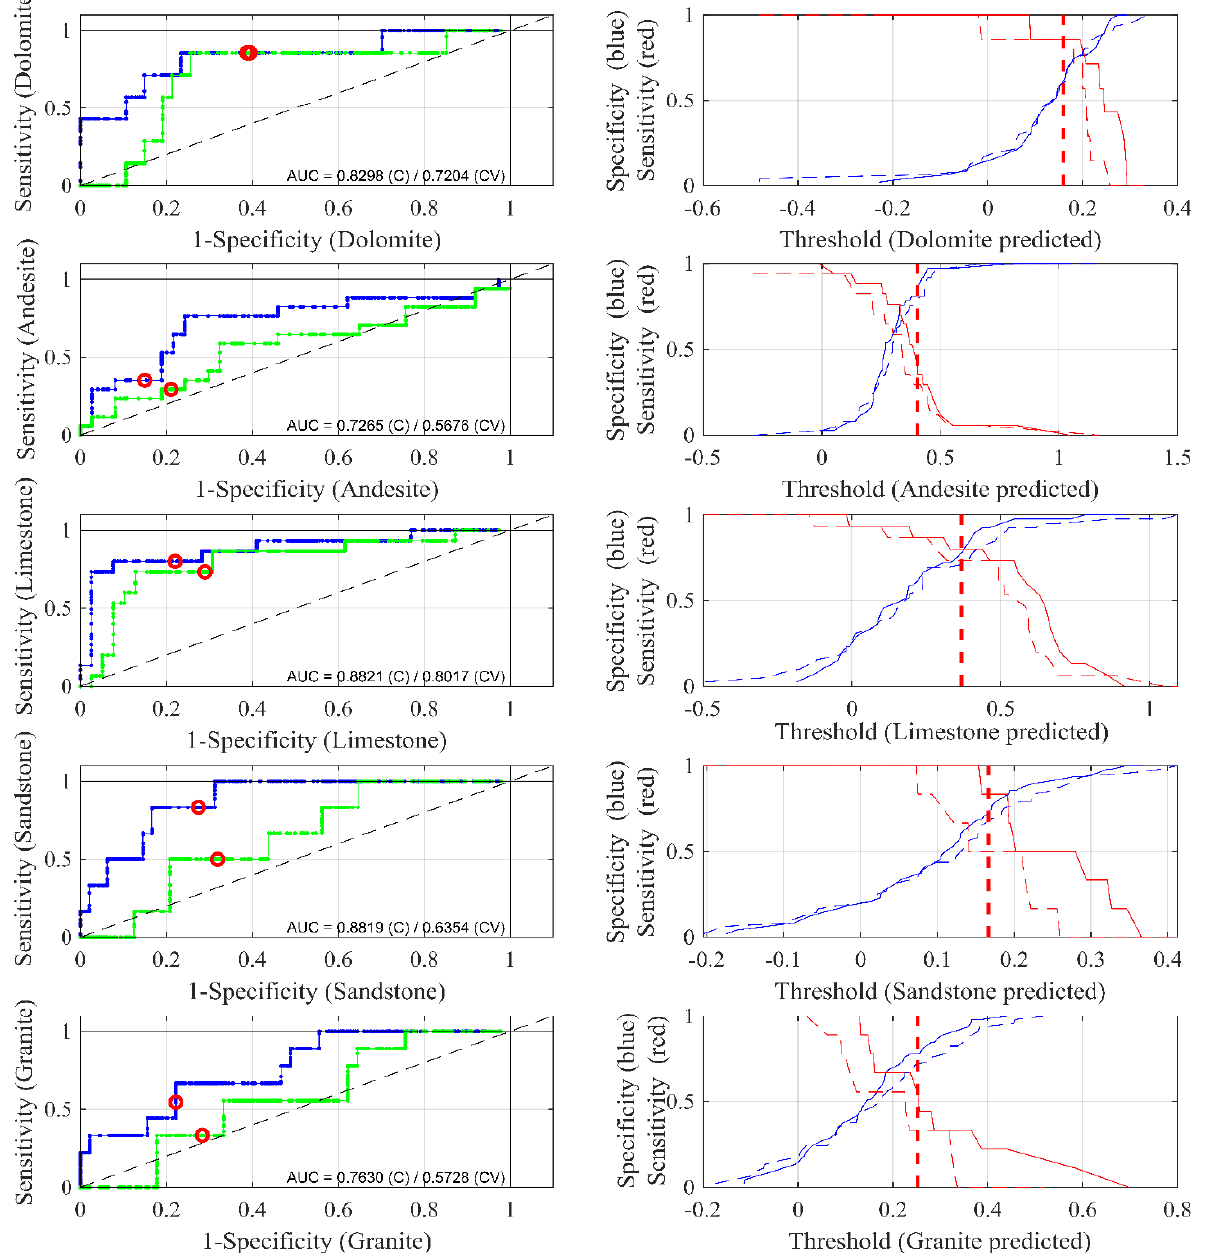
Figure 6. Estimated and cross-validated AUC-ROC curves of different rock classes (right) and the corresponding threshold plots of different rock classes (left). The red circles in the left column are model thresholds; the red vertical dash lines in the right column are also model thresholds.